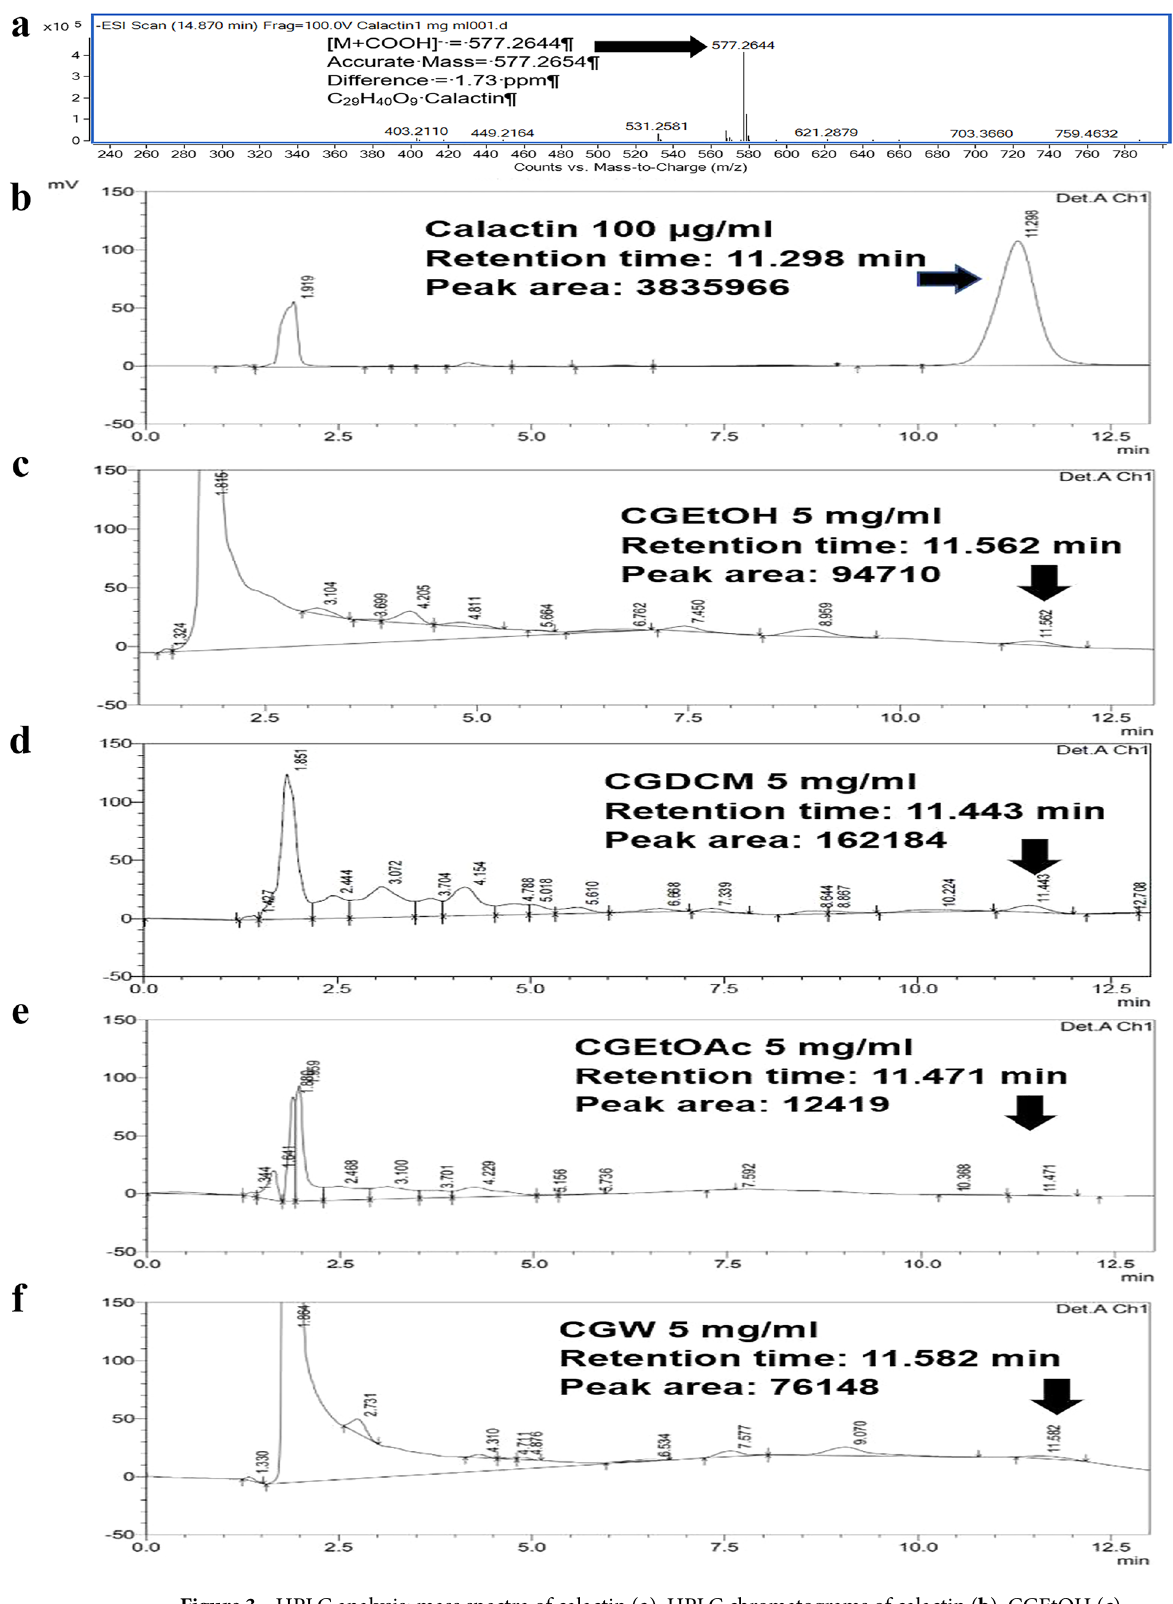
Figure 3. HPLC analysis: mass spectra of calactin ( a ), HPLC chromatograms of calactin ( b ), CGEtOH ( c ), CGDCM ( d ), CGEtOAc ( e ) and CGW ( f ), which are the total ethanolic extract, dichloromethane fraction, ethyl acetate fraction and water fraction of C. gigantea stem bark,